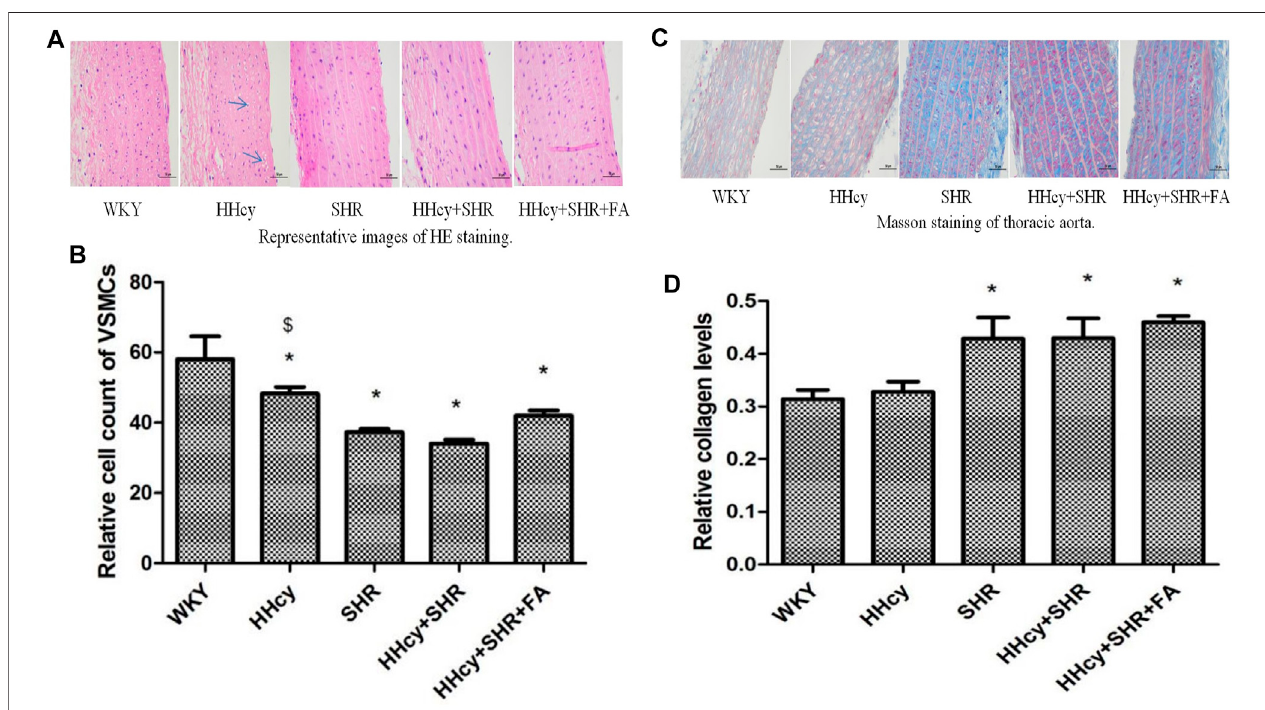
FIGURE 3 | Hematoxylin and eosin (HE) and masson staining of aorta in Wistar-Kyoto (WKY) group, hyperhomocysteinemia (HHcy) group, spontaneously hypertensive rat (SHR) group, HHcy + SHR group, and HHcy + SHR + folate (FA) group. (A) Representative images of HE staining of rat aorta (original magni fi cation, × 400). (B) Relativecellcountofvascularsmoothmusclecells(VSMC). (C) Representativeimagesofmassonstainingofrataorta(originalmagni fi cation, × 400). (D) Semi- quantitativeanalysisofcollagendeposition.Thedataarepresented asthemean ± SD(* p < 0.05vs.theWKYgroup, $ p < 0.05vs.theSHRgroup, & p < 0.05vs.the HHcy + SHR